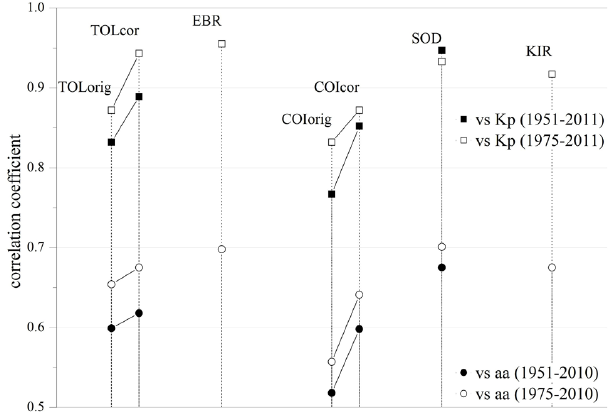
Fig. 6. Correlation coefficients between the local Ki series from five stations and two global geomagnetic indices, Kp (squares) and aa (circles), calculated for two periods: 1975–2010/2011 (open sym- bols) and 1951–2010/2011 (filled symbols). Results using the orig- inal and corrected series of both COI Ki and TOL Ki are